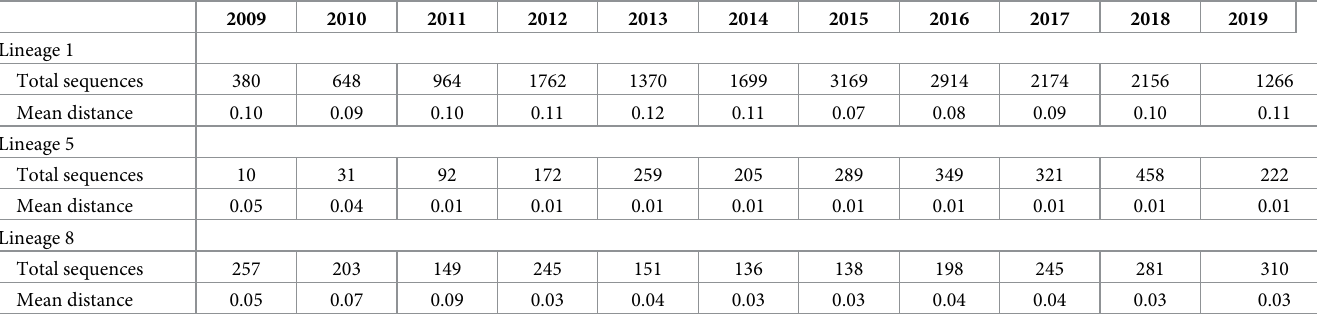
Table 2. Within-year mean ORF5 genetic distance as proportion nucleotide differences by lineage.